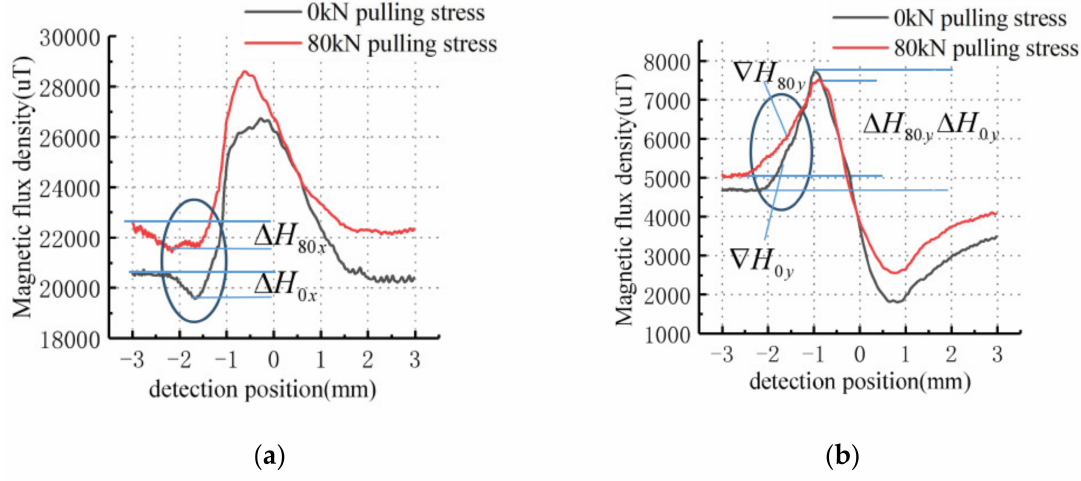
Figure 19. The MFL signals of specimen 1 under different stresses: ( a ) Tangential signal; ( b ) Normal